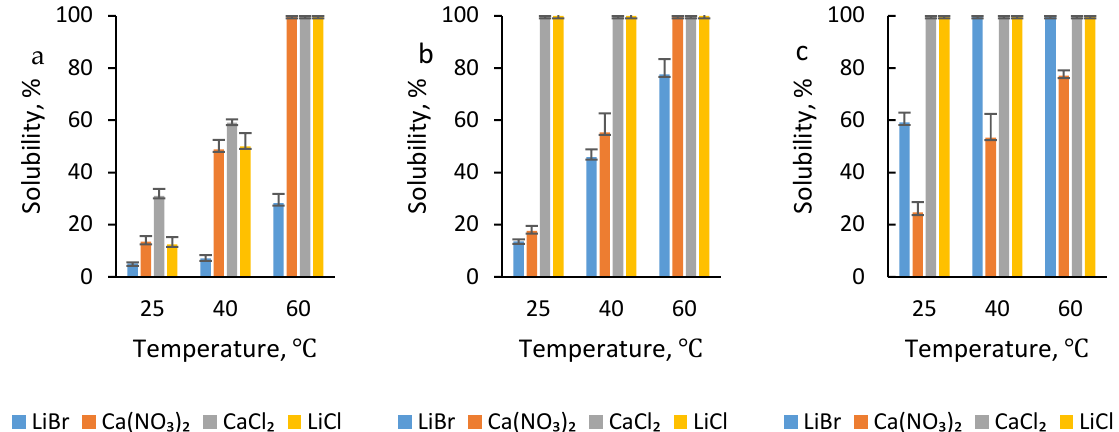
Figure 2. Solubility of silk fibroin at varying temperatures using salt–formic acid (FA) acid concentrations of ( a ) 1, ( b ) 3, and ( c ) 5 wt%.